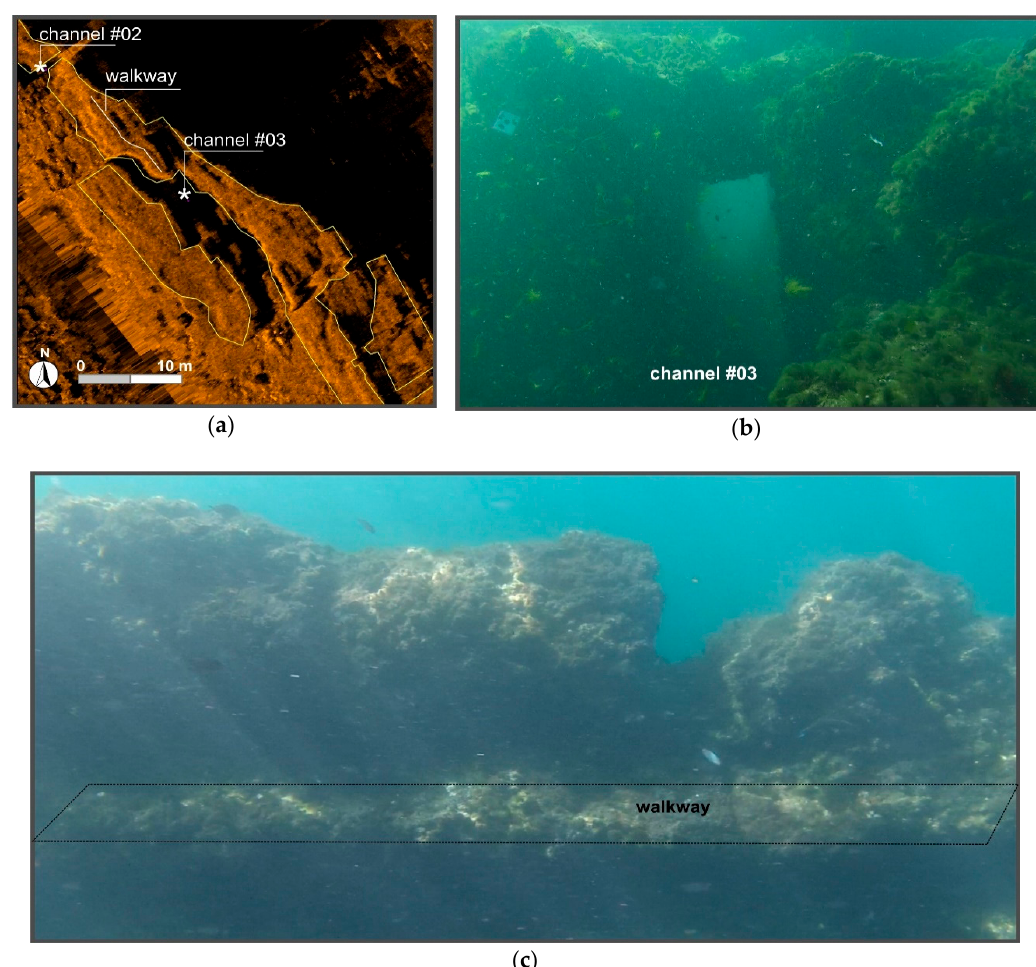
Figure 13. ( a ) SE zoomed sector of the map of the SSS mosaic; ( b ) underwater photo of channel #03; ( c ) underwater photo of the walkway between channel#02 and